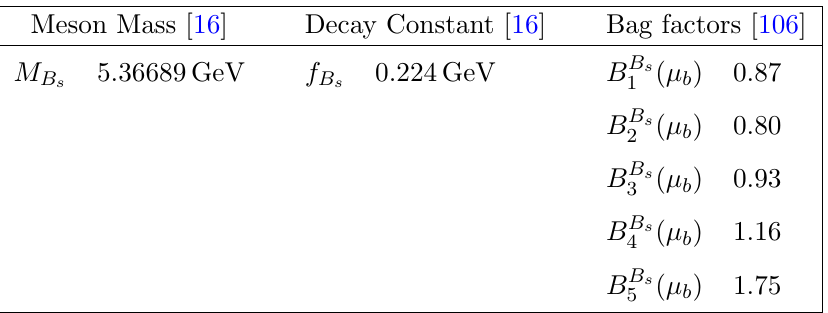
Table 9 . Values of B i ( (cid:22) ) are renormalised in the MS scheme. The B-meson decay constant and mass are also